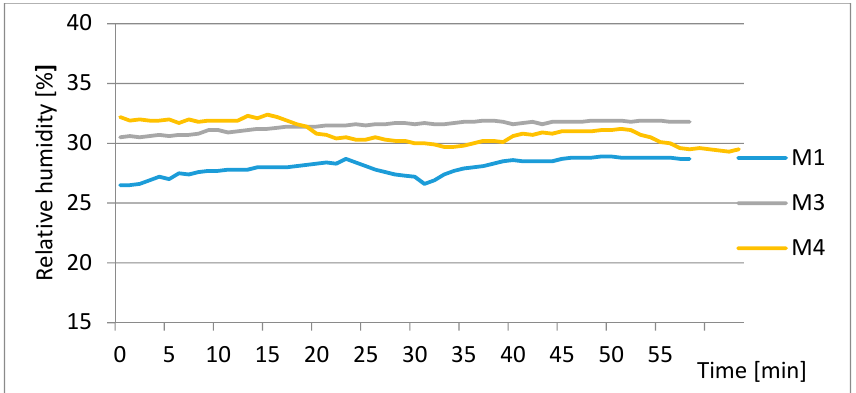
Figure 2. The distribution of relative humidity in the tested